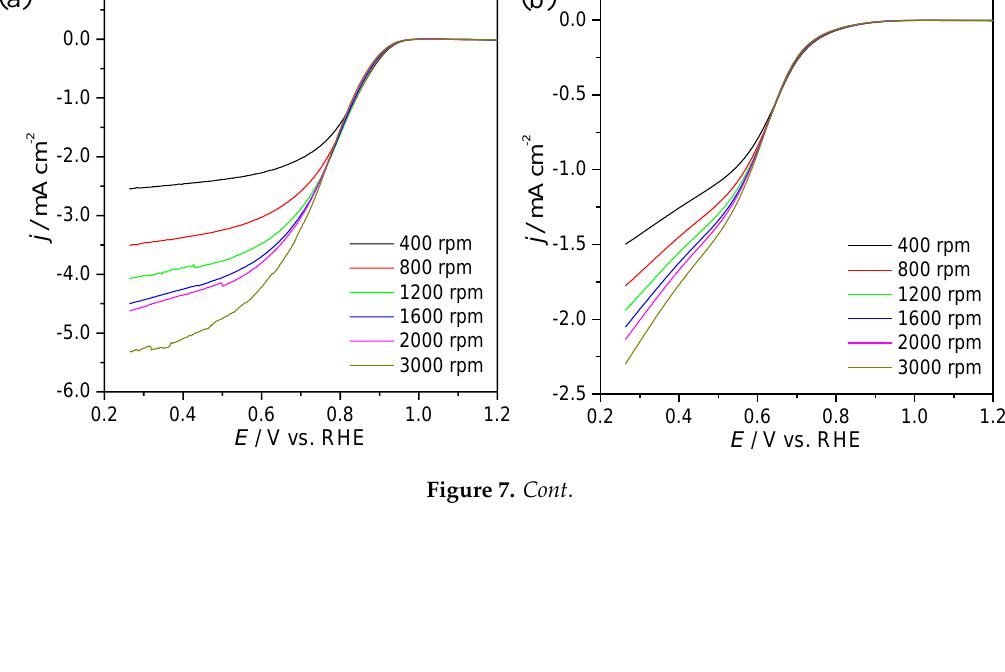
Figure 6. ORR LSV curves obtained in 0.1 mol dm -3 KOH saturated with O 2 for Pt/C, S 3 N 2 –GF, Co/S 3 N 2 –GF and Mn/S 3 N 2 –GF at 1600 rpm and 0.005 V s -1 ( a ) and the corresponding ORR Tafel plots ( b ).